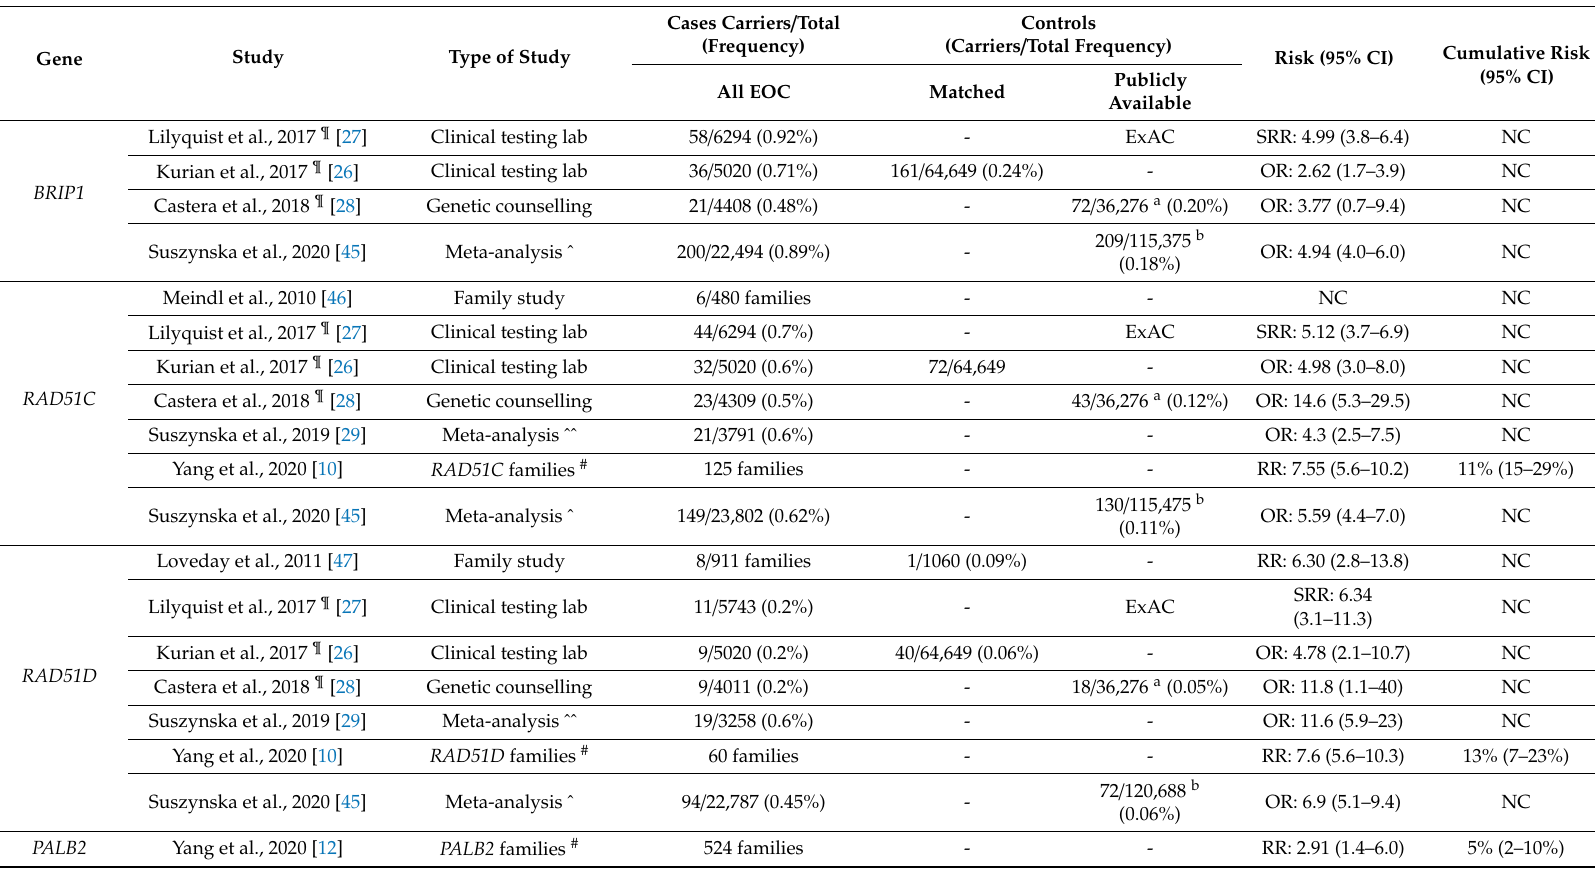
Table 2. Frequency of germline pathogenic variants in BRIP1 , RAD51C , RAD51D , and PALB2 , in EOC cases from family history